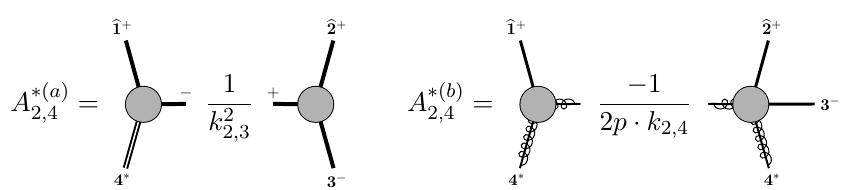
Figure 2 . BCFW contributions for A (cid:3)